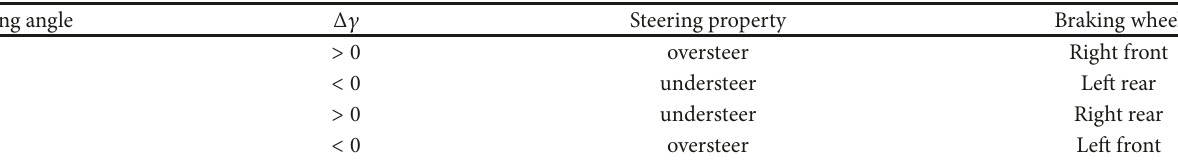
Table 3: Braking strategy of a bus.